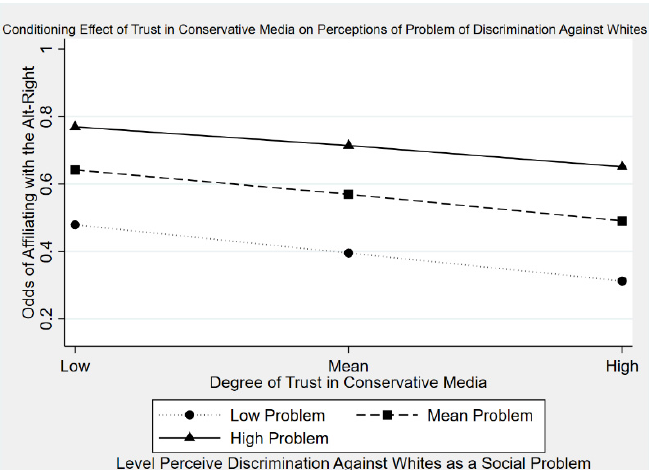
Figure 4. Conditioning Effect of Conservative Media: Discrimination against Women and the Alt-Right.